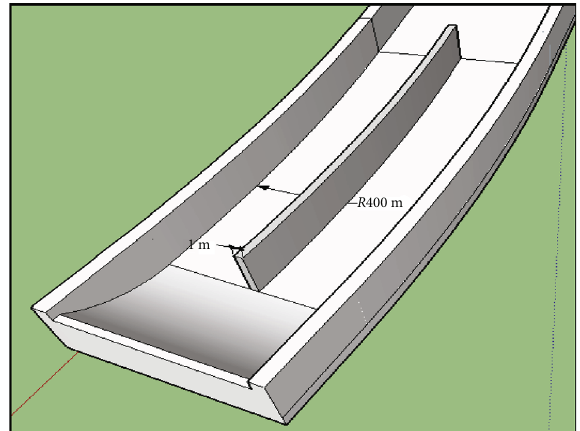
Figure 13: Geometry of the guide wall.